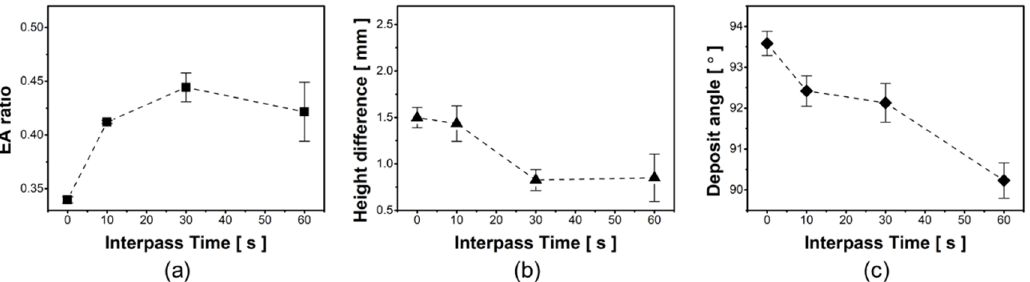
Figure 6. Experimental results as a function of interpass time: ( a ) the EA ratio, ( b ) height difference and ( c ) deposit angle.